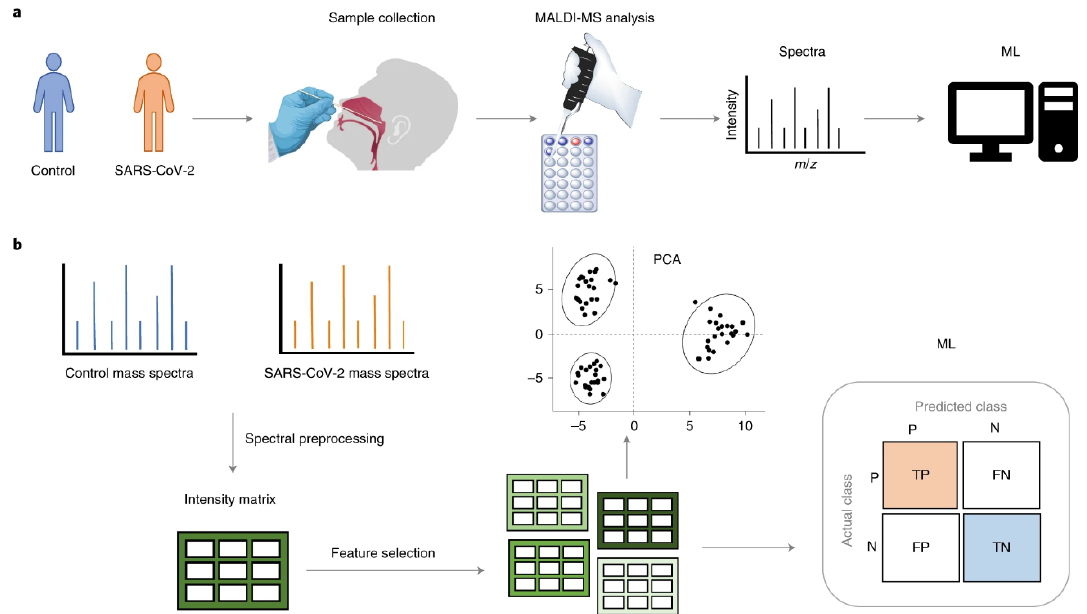
Figure 3. Representation of a standard MS workflow exemplified by SARS-CoV-2 detection in nasal mucous secretion. This figure was originally published in Nature Biotechnology. Nachtigall, F.M., Pereira, A., Trofymchuk, O.S. et al. Detection of SARS-CoV-2 in nasal swabs using MALDI-MS. Nat Biotechnol 38, 1168–1173 (2020). https://doi.org/10.1038/s41587-020-0644-7 ©Copyright Clearance Center. Reprint from [110].